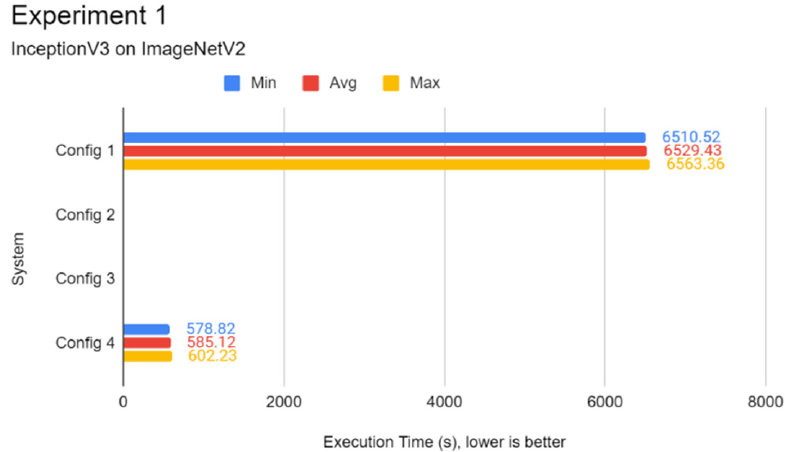
Figure A1. Bar chart execution time results for all systems running InceptionV3 on ImageNetV2 in Experiment 1. Configurations 2 and 3 are excluded due to Spark OOM error.